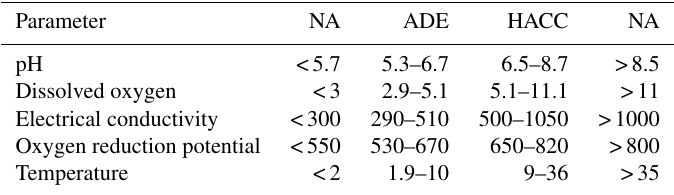
Table 3. Fuzzy representation of different